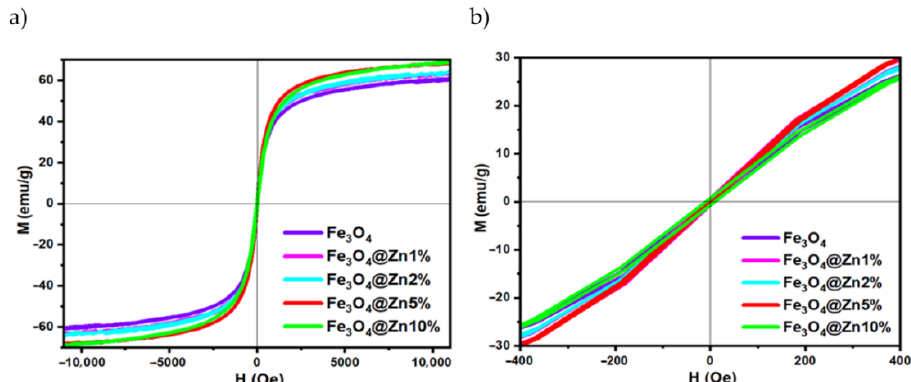
Figure 4. Magnetization curves of Fe 3 O 4 , Fe 3 O 4 @1%Zn, Fe 3 O 4 @2%Zn, Fe 3 O 4 @5%Zn, and Fe 3 O 4 @10%Zn at ( a ) full H range (from − 10 kOe to 10 kOe), and ( b ) narrow H range (from − 400 Oe to 400 Oe).